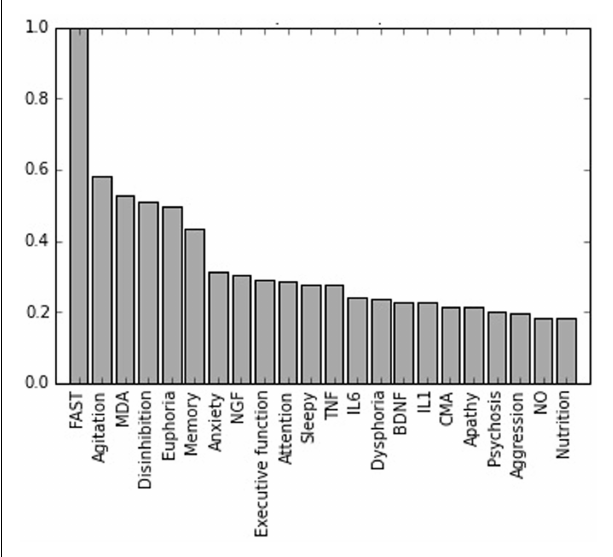
FIGURE 1 | Normalized feature importances in the BD vs. AD classification experiment